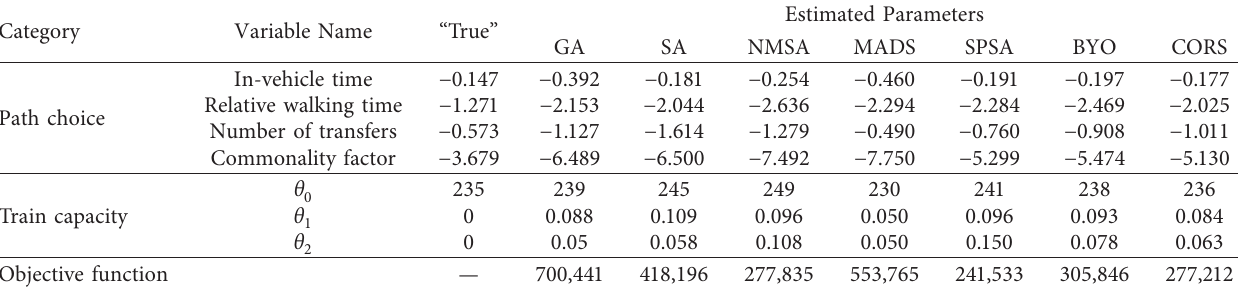
Table 7: Estimation results of the crowding-insensitive train capacity scenario.